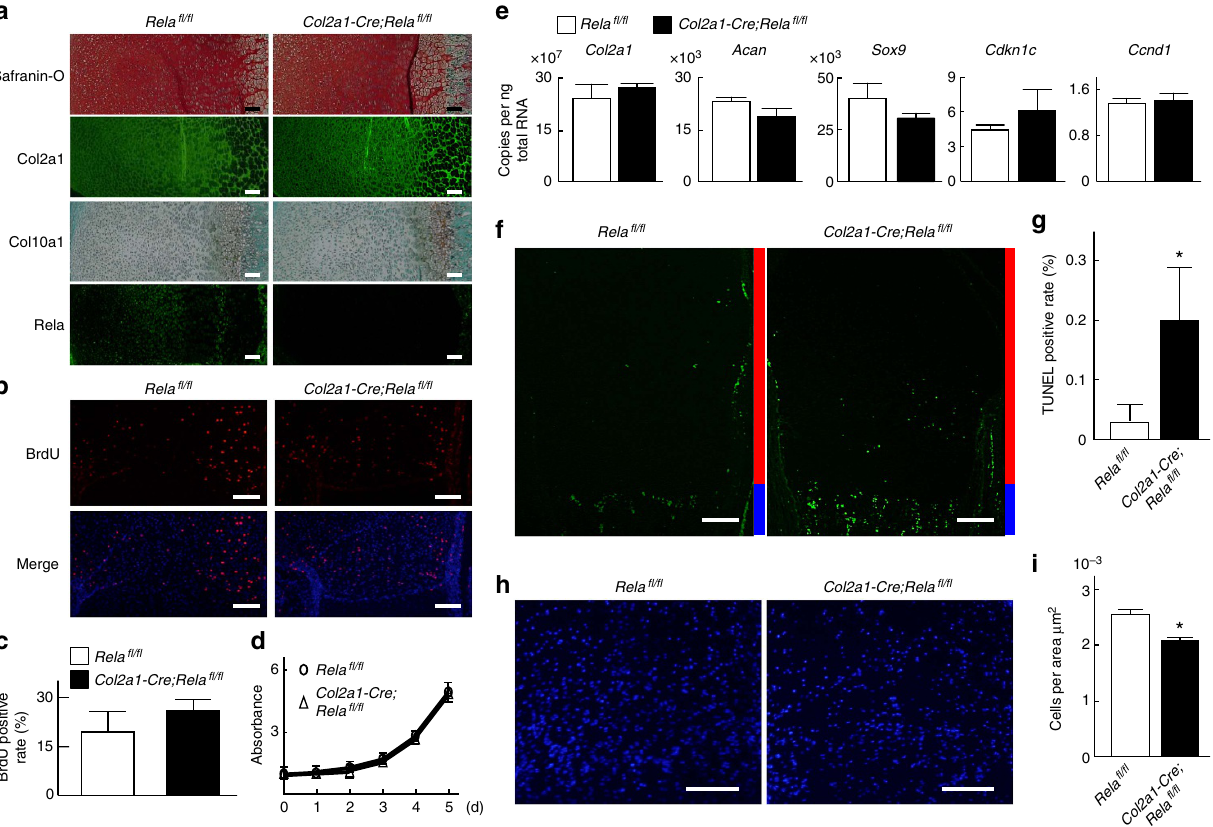
Figure 3 | Enhanced apoptosis in epiphyseal cartilage of Col2a1-Cre; Rela fl/fl embryos. ( a ) Safranin-O staining and immunostaining of Col2a1, Col10a1 and Rela in proximal tibias of Rela fl/fl and Col2a1-Cre; Rela fl/fl littermate embryos (E18.5). The images are representative of three independent experiments. Scale bars, 100 m m. BrdU staining ( b ), and the rate of BrdU-positive cells ( c ) in the proliferative zone of proximal tibias of Rela fl/fl and Col2a1-Cre; Rela fl/fl littermate embryos (E18.5). The images are representative of three independent experiments. Scale bars, 100 m m. Data are expressed as means ± s.d. of three sections per group. ( d ) Cell proliferation curves determined by a CCK-8 assay during 5 days of culture of primary chondrocytes derived from Rela fl/fl and Col2a1-Cre; Rela fl/fl littermates. Data are expressed as the mean ± s.d. of three sections per group. ( e ) mRNA levels of Col2a1 , Acan , Sox9 , Cdkn1c and Ccnd1 in primary chondrocytes derived from Rela fl/fl and Col2a1-Cre; Rela fl/fl littermates. Data are expressed as the means ± s.d. of three wells per group. TUNEL staining ( f ), and the rate of TUNEL-positive cells ( g ) of proximal tibias of Rela fl/fl and Col2a1-Cre; Rela fl/fl littermate embryos (E18.5). Scale bars, 100 m m. Data are expressed as the means ± s.d. of three sections per group. * P o 0.05 versus Rela fl/fl mice; Student’s t -test. 4,6-diamidino-2-phenylindole (DAPI) staining ( h ), and the number of DAPI-positive cells ( i ) in proximal tibias of Rela fl/fl and Col2a1-Cre; Rela fl/fl littermate embryos (E18.5). The images are representative of three independent experiments. Scale bars, 100 m m. Data are expressed as the means ± s.d. of three sections per group. * P o 0.05 versus Rela fl/fl mice; Student’s t